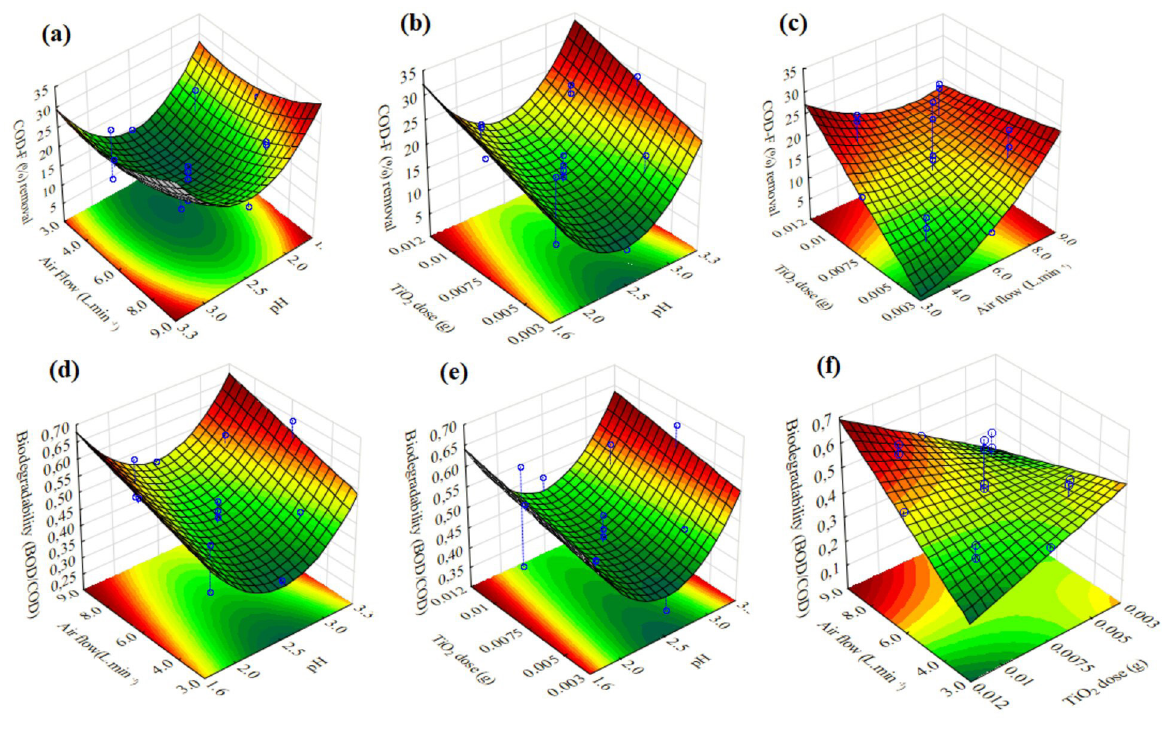
Figure 1. Response surfaces obtained by statistical model for COD-F (%) removal and biodegradability increase (BOD/COD). For COD-F (%) removal: (a) pH versus air flow; (b) pH versus TiO For biodregadability increase: (d) pH versus air flow; (e) pH versus TiO